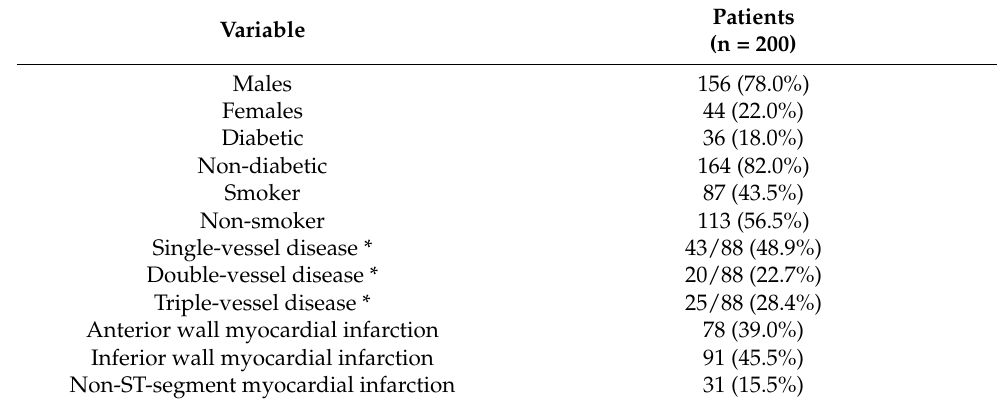
Table 1. Demographics of study patients.